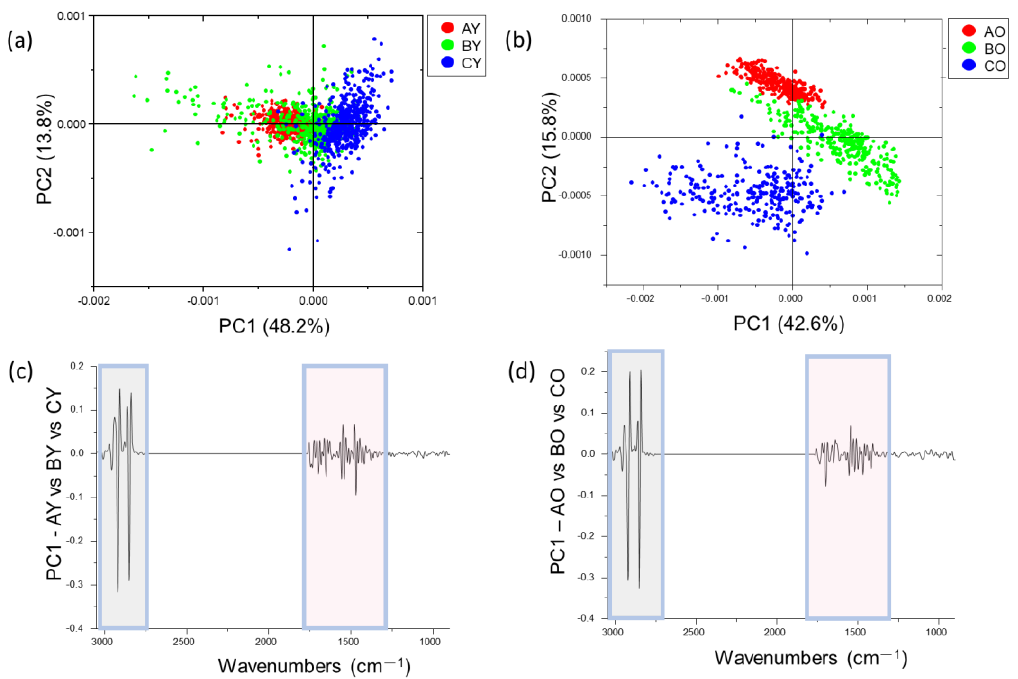
Figure 1. Principal component analysis of A , B, and C spectral populations of Y and O CC samples: ( a , b ) PCA scores plots in the 3050–900 cm − 1 range and ( c , d ) corresponding PC1 loadings.